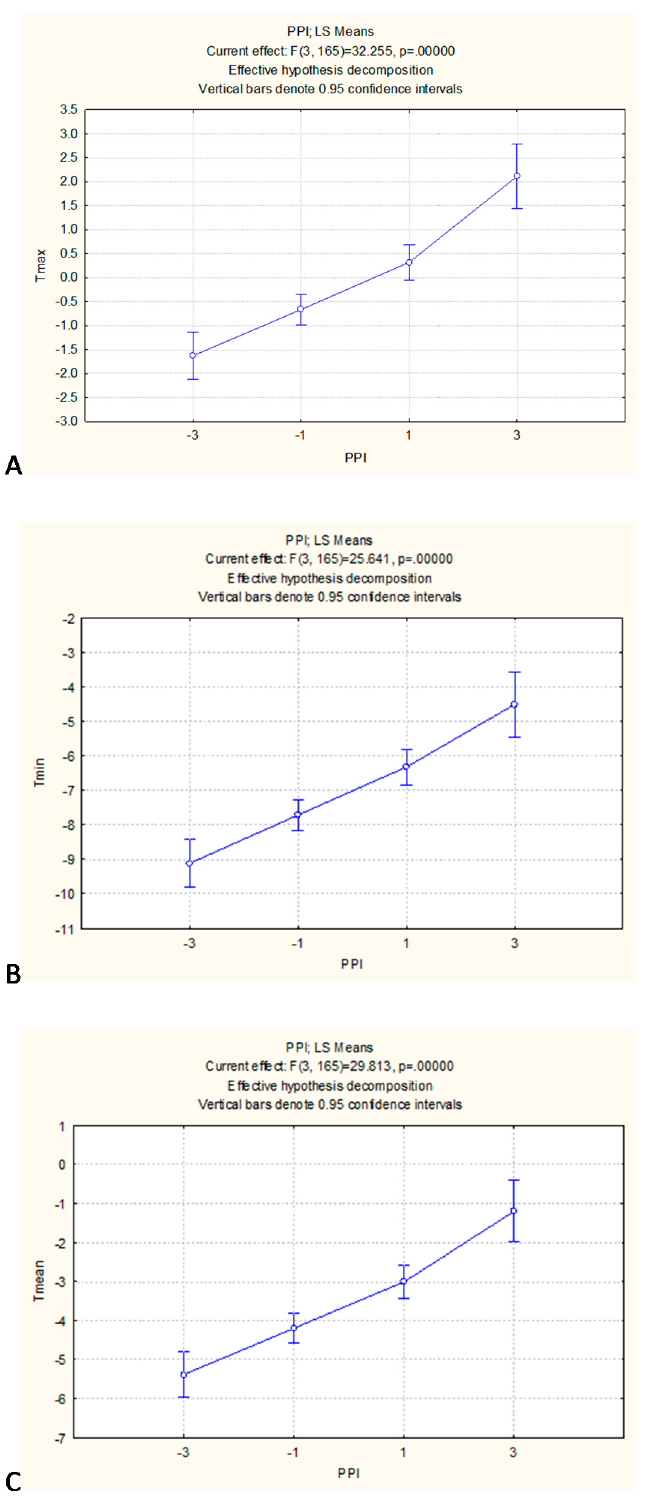
Figure 5. Correlations between winter temperatures ( A . Tmax, B . Tmin, C . Tmean) and the precipitation phase index (PPI) in Toronto from 1849 to 2017.